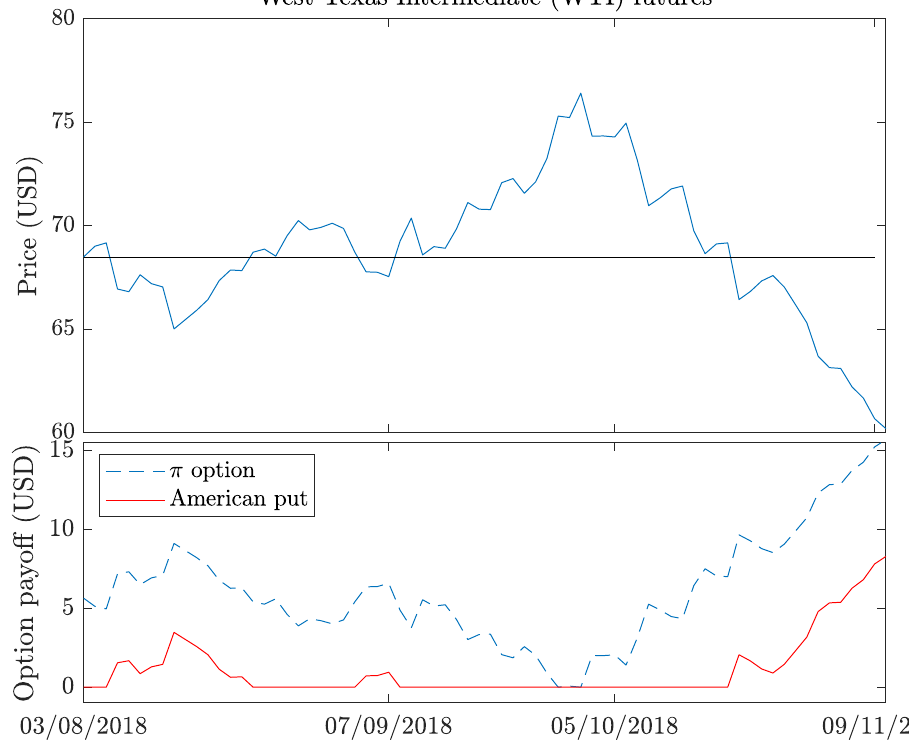
Figure 11. WTI crude oil futures contract closing prices ( top ) and the corresponding payoffs of π -option on relative drawdown and American put ( bottom ) with the parameters from Table